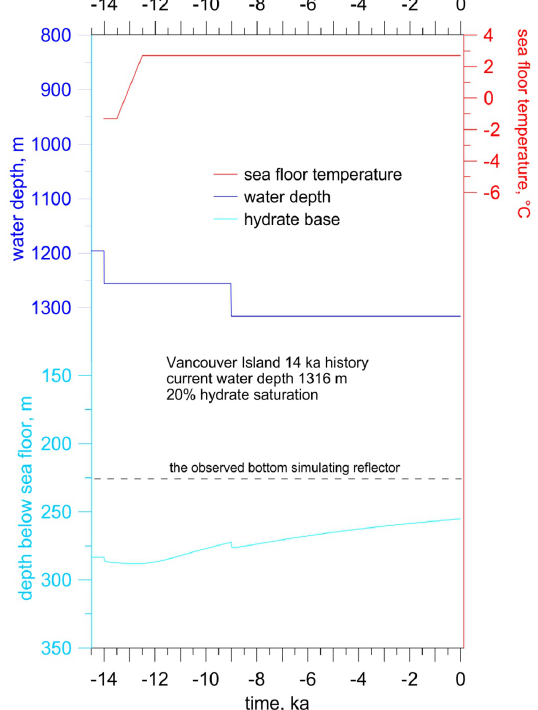
Figure 3. Modeling of GH response to the changing sea floor temperature and the increasing sea level since 14 thousand years (kyrs) ago on the continental shelf, offshore Vancouver